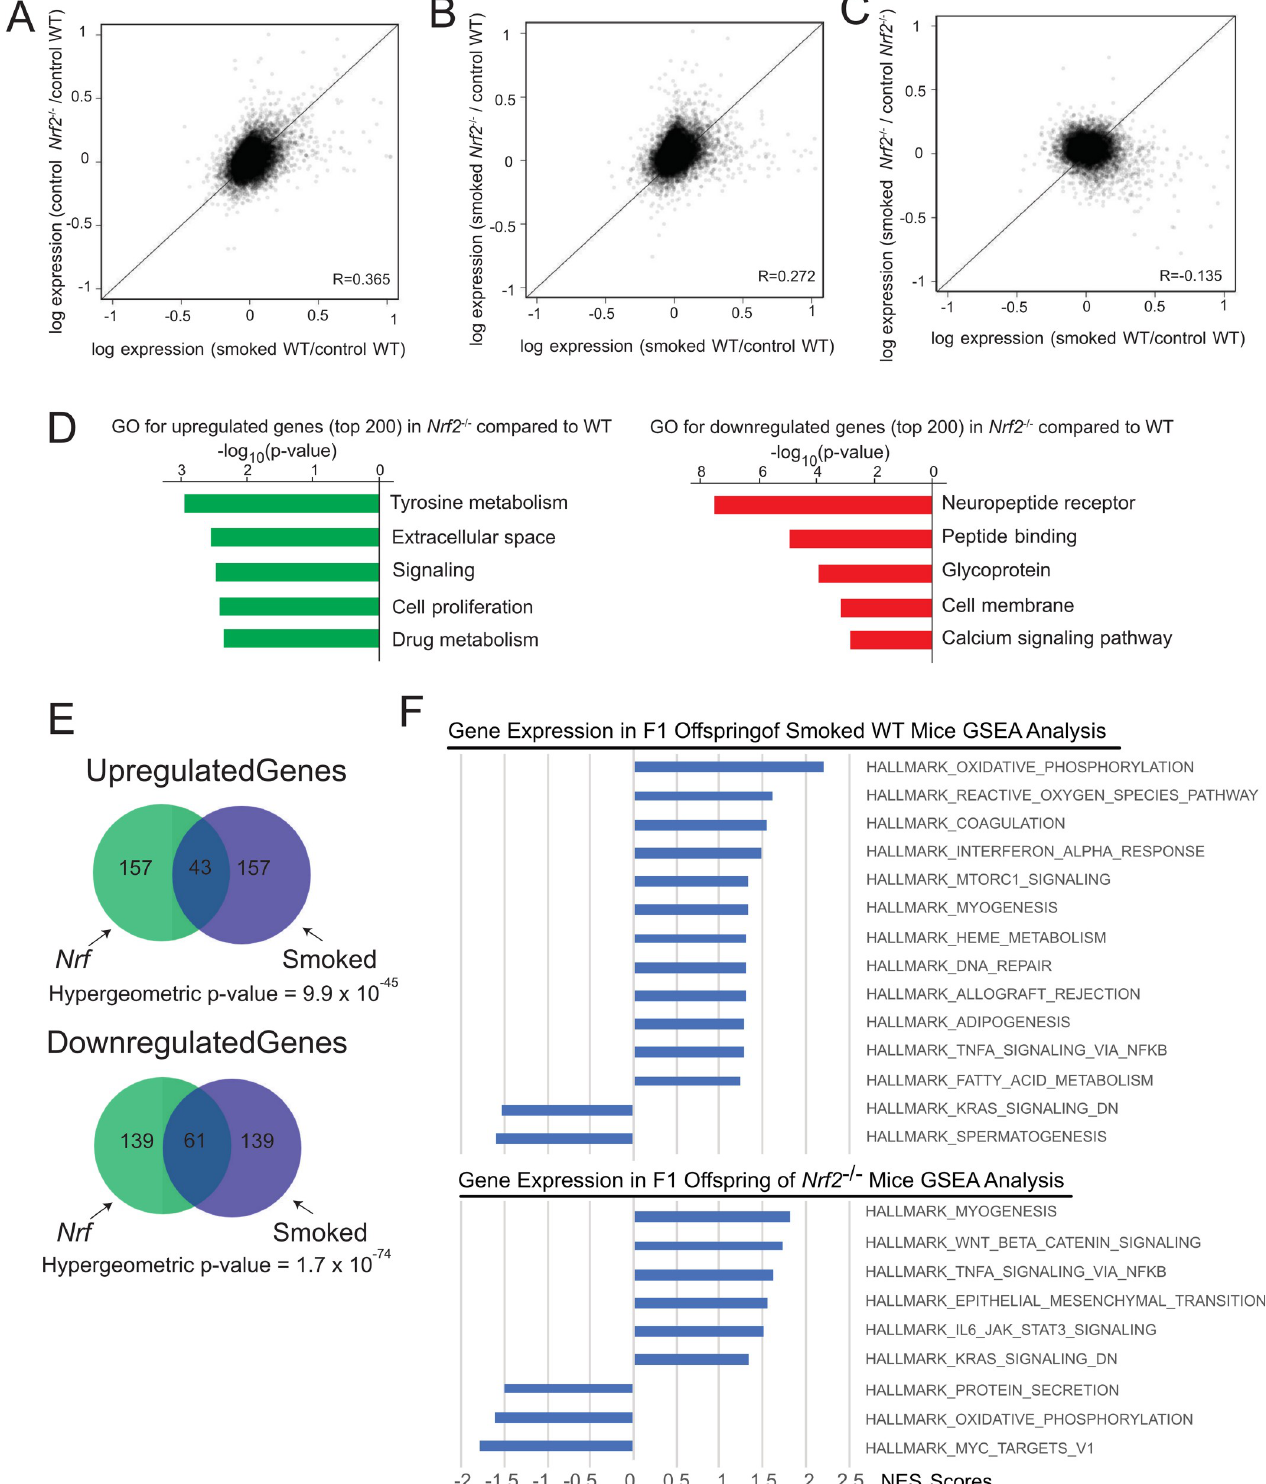
Fig 4. Prefrontal cortex gene expression variation and correlation closely reflect the themes observed in F0 sperm. A) A significant correlation in gene expression was observed between offspring of CS-exposed WT mice and control Nrf2 -/- mice. B) Likewise, the correlation was observed between CS-exposed WT and Nrf2 -/- offspring. C) However, there was no correlation in gene expression changes when comparing offspring of CS-exposed and unexposed Nrf2 -/-